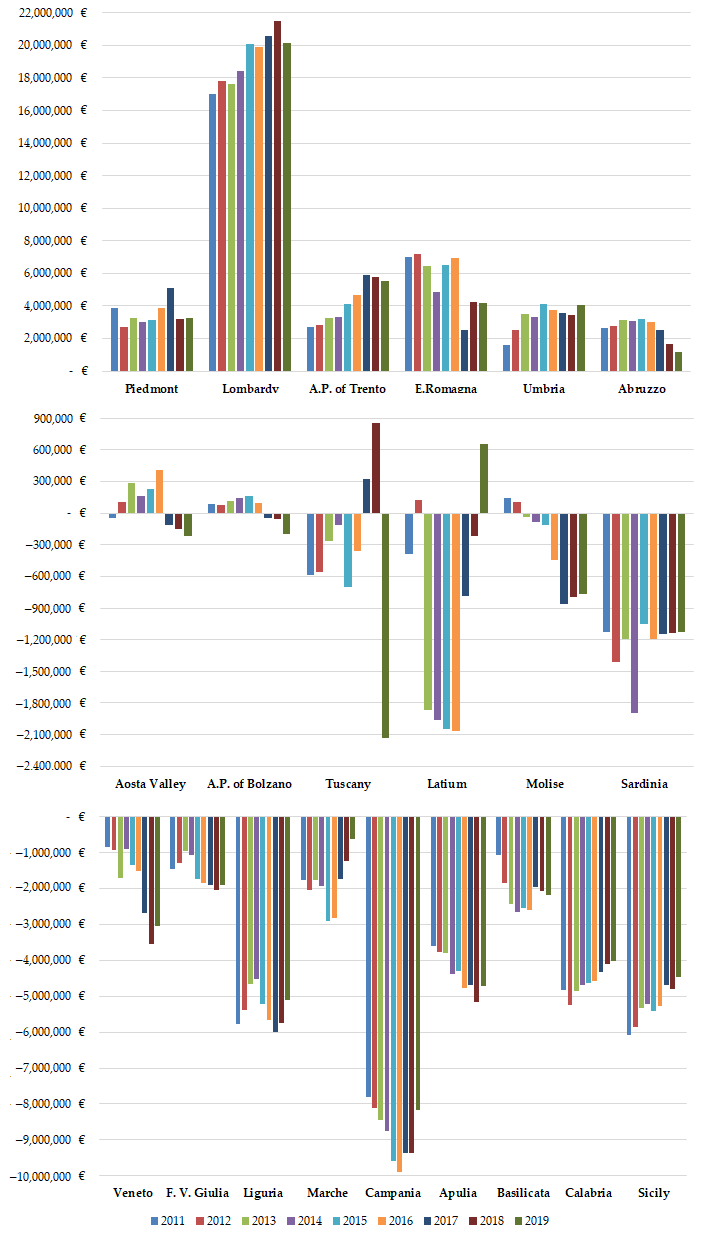
Figure 3. Financial mobility balance (A–F) of Italian regions for hospital orthopedic intensive rehabil- itation from 2011 to